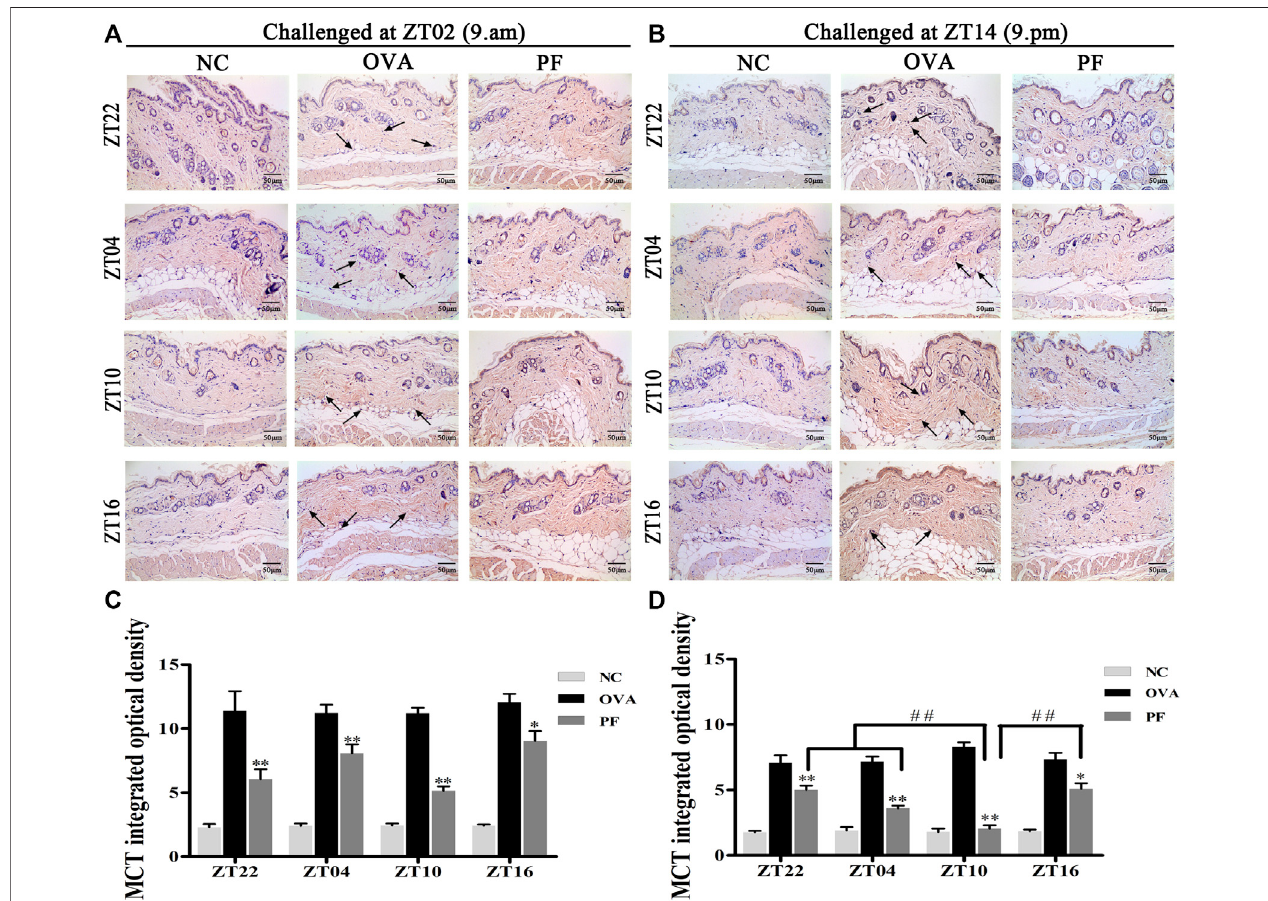
FIGURE 5 | Representative low-magni fi cation light photomicrographs (A,B) and integrated optical density (C,D) displaying immunohistochemistry of mast cell tryptase (MCT) (black arrows). The PF treatment at ZT10 did possess the best effect on the release of MCT than the other three PF circadian time points. Data are expressed as mean ± SEM ( n (cid:1) 6). *p < 0.05, **p < 0.01 versus OVA mice at the same time points. ## p < 0.01 represents the comparison of PF ZT10 versus the other three PF groups. The magni fi cation was ×